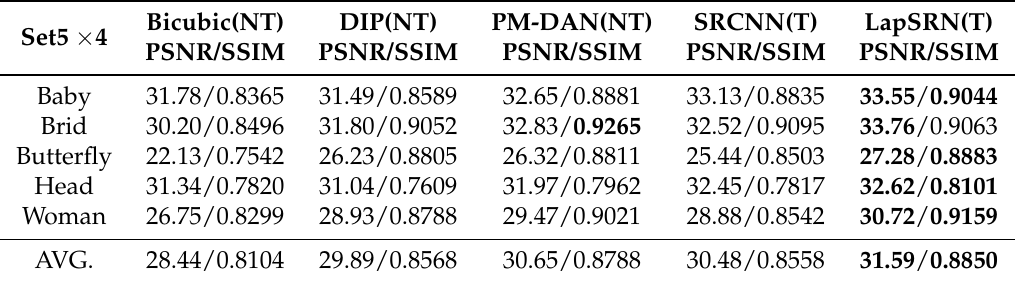
Table 3. 4 × SR comparison on Set5. The best PSNR and SSIM values are highlighted in bold.